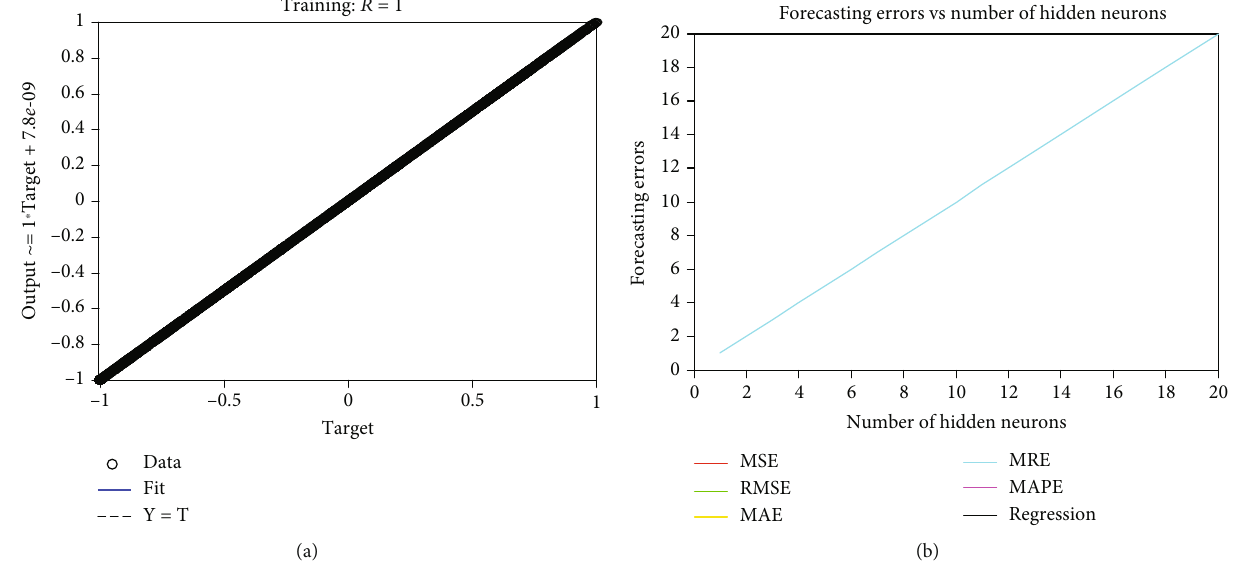
Figure 12: (a) Four input MLPNN-based forecasting model regression graphs. (b) Four input MLPNN-based forecasting model forecasting error vs. the number of hidden neurons.